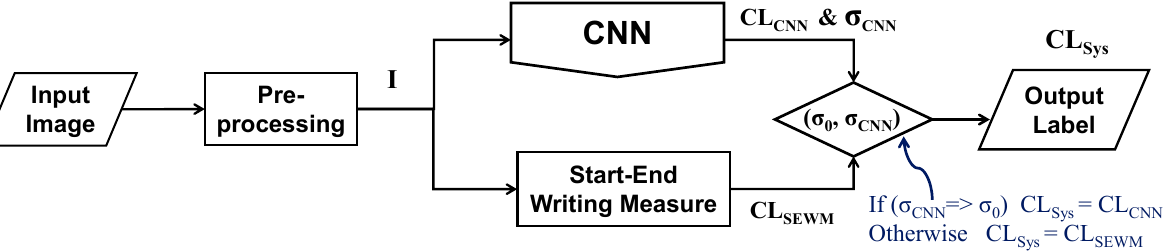
Figure 1. Structure of the proposed HNR method integrating Start–End Writing Measure with CNN.